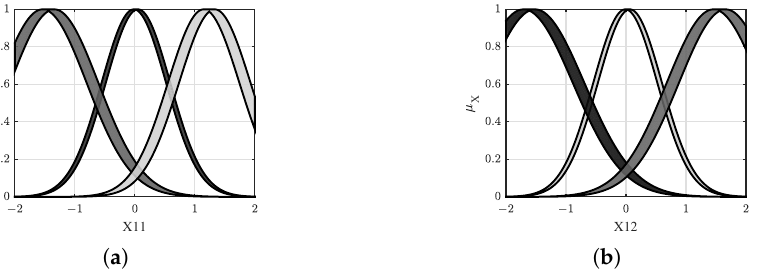
Figure 7. Fuzzy set of the SOFS1 in 4.2. ( a ) Fuzzy set of SOFS1’s first dimension. ( b ) Fuzzy set of SOFS1’s second